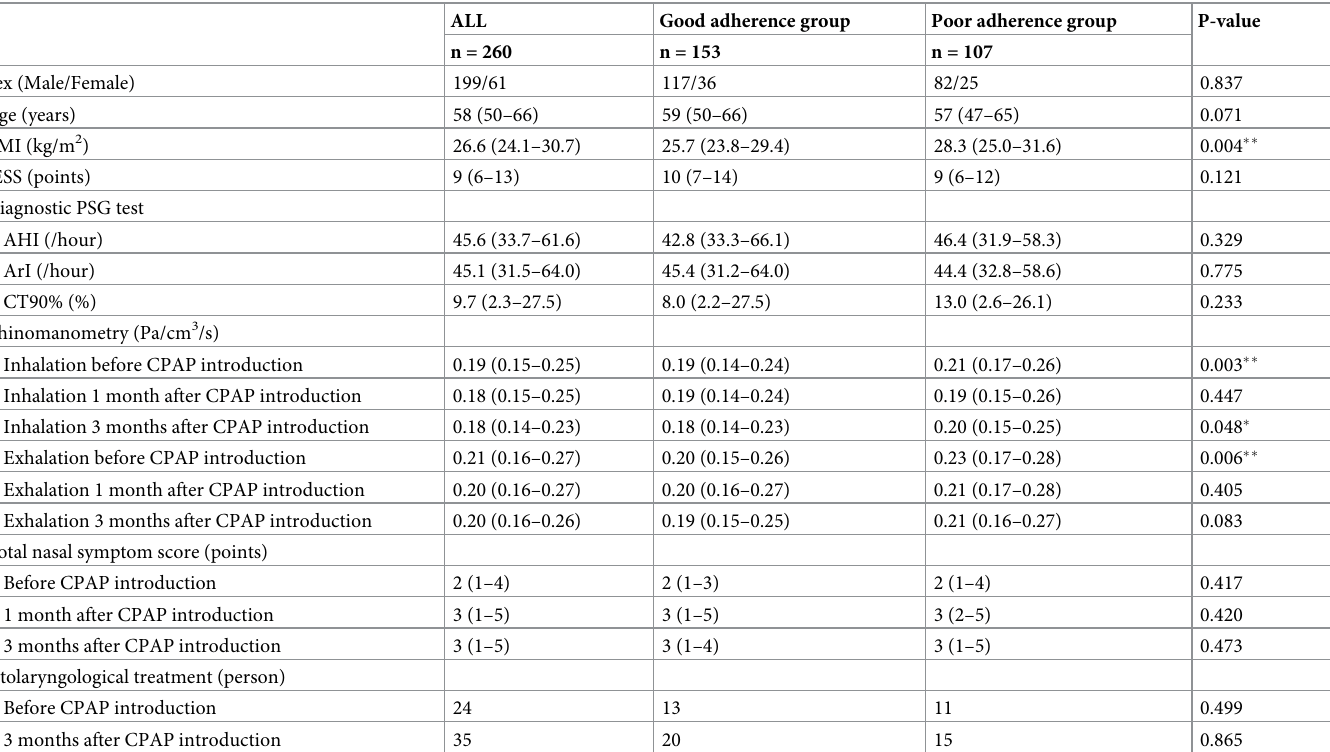
Table 1. Patient background by CPAP adherence at